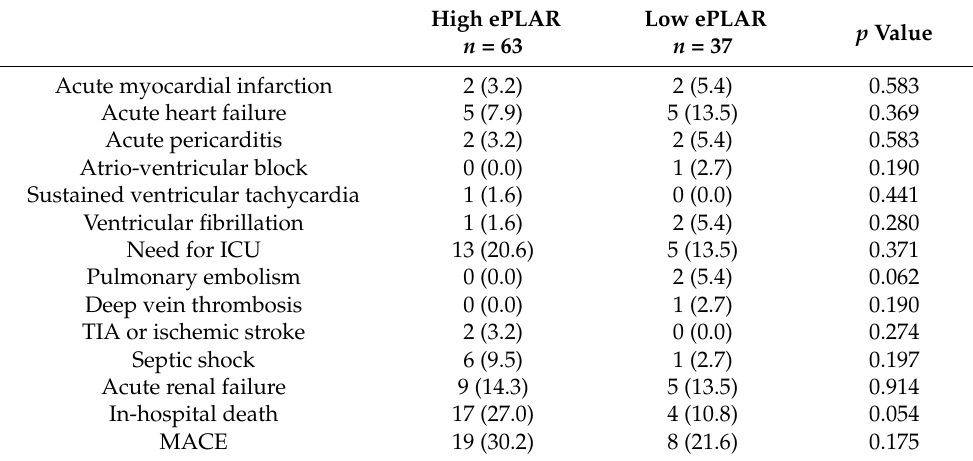
Table 3. In-hospital adverse events according to